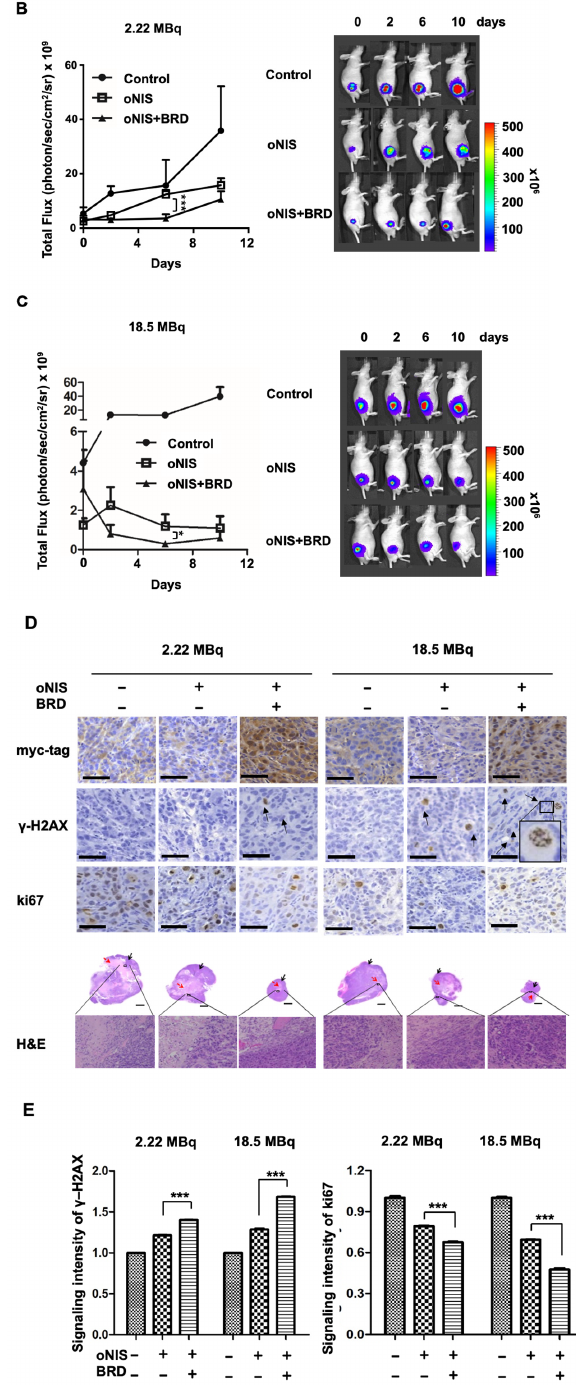
Figure 3. Radiation sensitization by BRD after low-dose (2.22 MBq) or high-dose (18.5 MBq) I-131 treatment. ( A ) Tumor volumes were measured with a caliper up to 10 days after treatment with 2.22 MBq or 18.5 MBq I-131. ( B , C ) A region of interest (ROI) was measured to quantify the luminescent signal from the tumors. The bioluminescence signal of the IVIS 100 correlated with the cell number after I-131 treatment. The scale bar represents the peak signal in photons/s/cm 2 /sr. ( D ) Tumor sec- tions (4 μ m in thickness) were stained with antibodies against myc-tag, ki67, and γ -H2AX. Scale bar for IHC = 50 μ m. Scale bar for tissue = 2 mm. ( E ) Quantification of γ -H2AX or ki67 intensity in tumor tissues from D using TissueFAXS software. Values are means ± S.E.M. p < 0.001 (***), p < 0.05 (*). 2.3. Immunostained Tumor Sections Show an Increase in DNA DSBs and Fewer Proliferating Cells after I-131 Treatment in the Presence of oNIS+BRD In the mouse xenograft model, the size of the extracted tumors decreased signifi- cantly after oNIS overexpression followed by BRG1-BRD overexpression (Figure 3D). His- tological analysis of tumor sections showed that DNA DSBs, as represented by the γ - H2AX marker, increased 1.4-fold (2.22 MBq) and 1.3-fold (18.5 MBq) in the oNIS+BRD group and the oNIS alone group, respectively, after I-131 treatment ( p < 0.005) (Figure 3E). Expression of the proliferation marker ki67 was assessed to measure the growth fraction of cells from a xenograft model after radioactive iodine treatment, and its expression was significantly decreased in cells that overexpressed oNIS+BRD ( p < 0.005) compared with cells that overexpressed oNIS alone in both the low-dose and high-dose I-131 treatment groups, which supports the results observed in Figure 2A,B (Figure 3D,E).